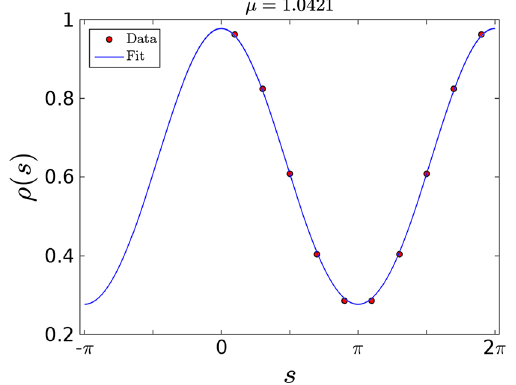
Fig. 3 Same as previous figures but in the strong sign-problem regime. The blue band corresponds to the 1 − σ region obtained from the fit 3 The Gaussian